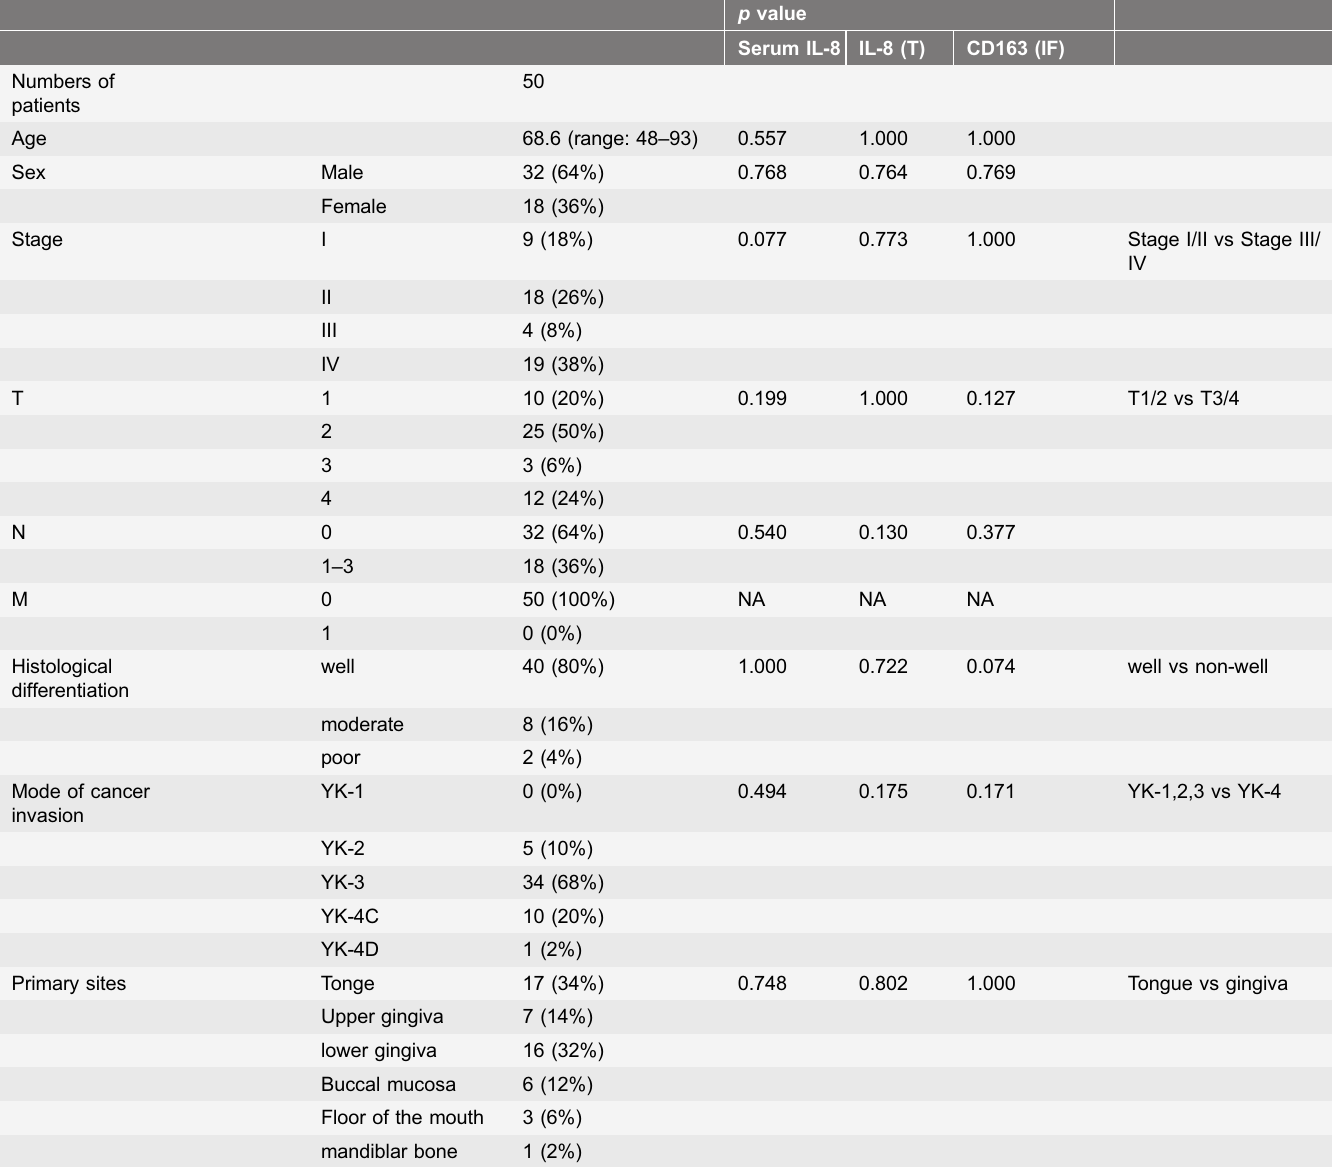
Table 1. The clinicopathological characteristics of the OSCC